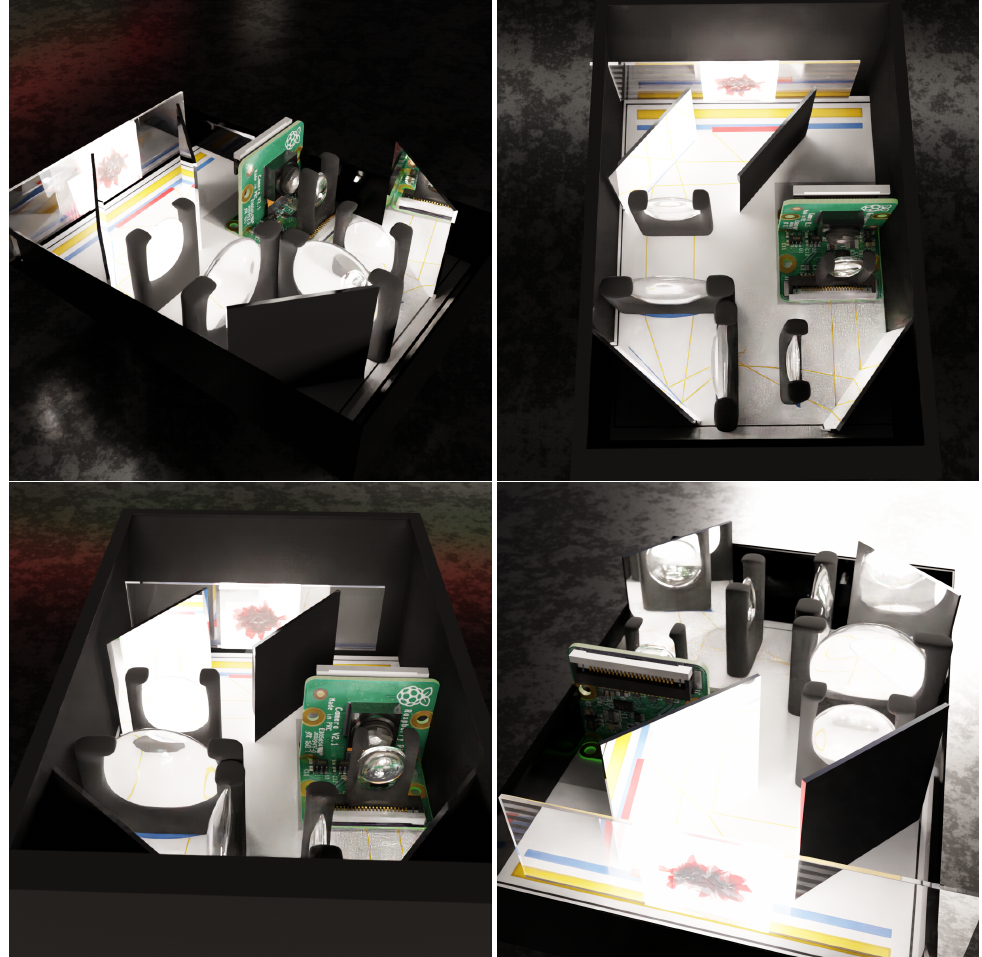
Figure 4. The images above show the generated images of the developed device. A micro-microscope, a type of microscope that is designed to be small and portable, is easy to use in resource-limited settings or in the field. It consists of a set of mirrors and lenses that are arranged in such a way so as to allow for the size of the lens to be reduced, while still providing a high level of magnification. This enables the microscope to be used to examine small samples, such as blood smears, for the presence of malaria